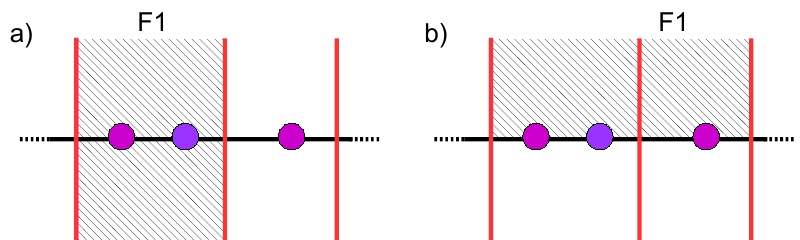
Z (cid:0) = Z 1 Z 2 X 4 X 5 , (b) Z + [12] [12]